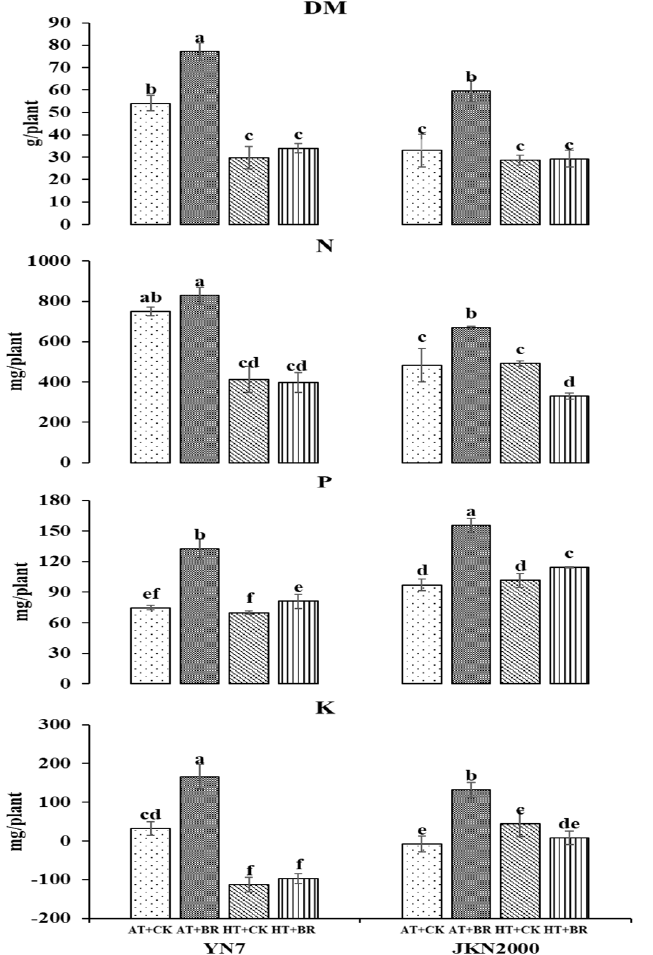
Figure 3. Effects of exogenous BR application at the silking stage on the post-silking DM and nutrients accumulation of waxy maize under post-silking ambient and high temperatures. YN7, Yunuo7; JKN2000, Jingkenuo2000; AT, ambient temperature; HT, high temperature; CK, control, plants sprayed with 100 mL water; BR, brassinolide, plants sprayed with 100 mL 0.25 mg/L BR. Within columns, those followed by the same letters are not significantly different ( p < 0.05).